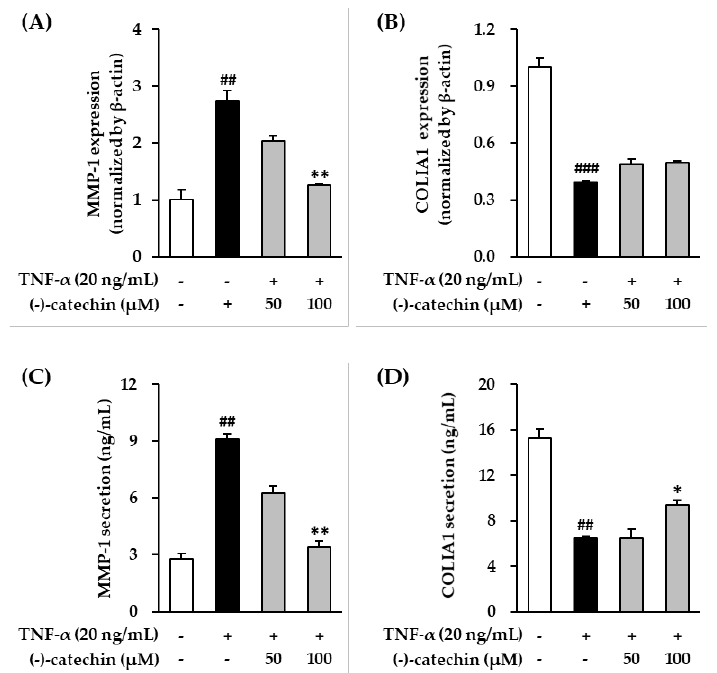
Figure 2. E ff ect of (-)-catechin on MMP-1 and COLIA1 mRNA and protein expression in tumor necrosis factor- α (TNF- α )-stimulated normal human dermal fibroblasts (NHDFs). ( A , B ) The NHDFs were treated with 50 and 100 µ M (-)-catechin for 1 h, and then with 20 ng / mL TNF- α for 4 h. The matrix metalloproteinase-1 ( MMP-1 ) and procollagen I α 1 (COLIA1 ) mRNA levels were measured by qRT-PCR. ( C , D ) The NHDFs were treated with 50 and 100 µ M (-)-catechin for 1 h, and then with 20 ng / mL TNF- α for 12 h. The MMP-1 and COLIA1 levels were measured using an ELISA kit. The data are presented as mean ± SEM (N = 3). ## p < 0.01 and ### p < 0.001 compared with the untreated group; * p < 0.05 and ** p < 0.01 compared with the TNF- α -treated group.